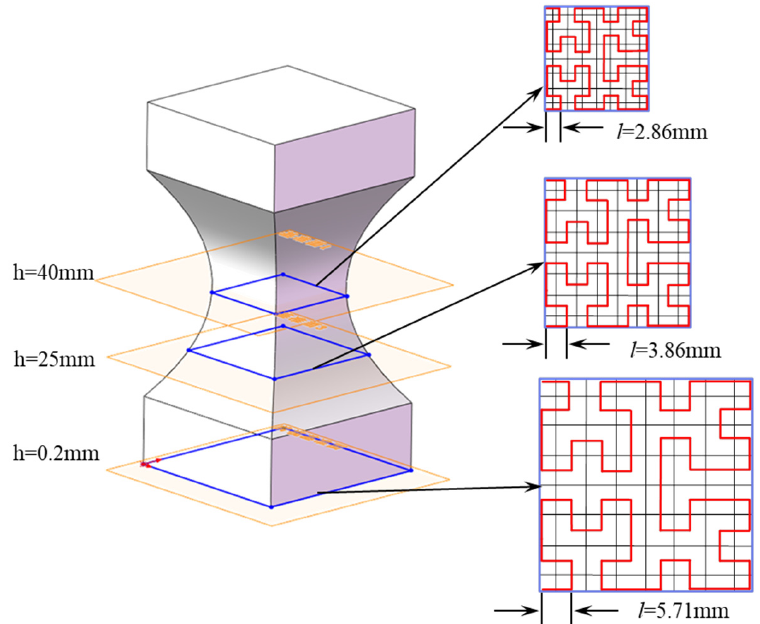
Figure 4. The side lengths of Hilbert curves with different orders ( n = 1, 2, 3 from left to right), the black solid line, and the blue dash-dotted line denote the original and magnified square, respectively, and the red line denotes the generated Hilbert curves.